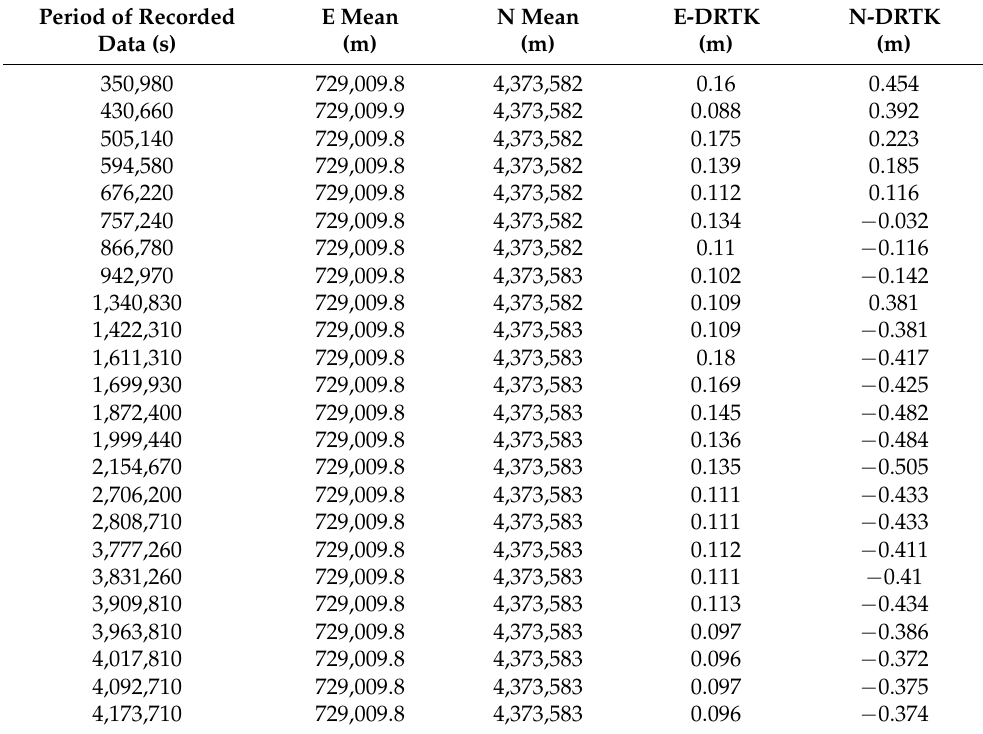
Table A1. Garmin Etrex 30 device period of recorded data, and the coordinate means for E and N. Differences between the reference data and coordinates mean (E-DRTK and N-DRTK). Real-time techniques were used to obtain the reference data: 729,009.945 m, 4,373,582.379 m. Period of